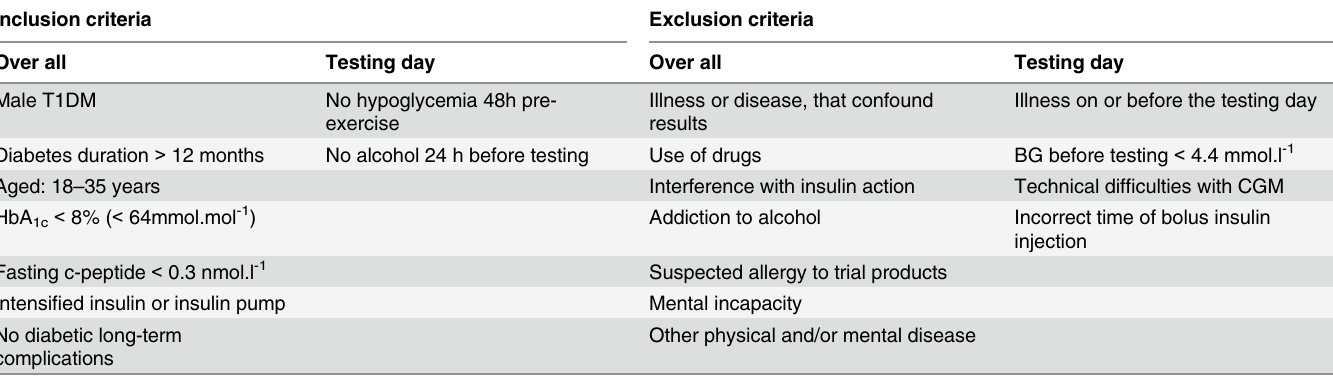
Table 3. (Testing day) inclusion and exclusion